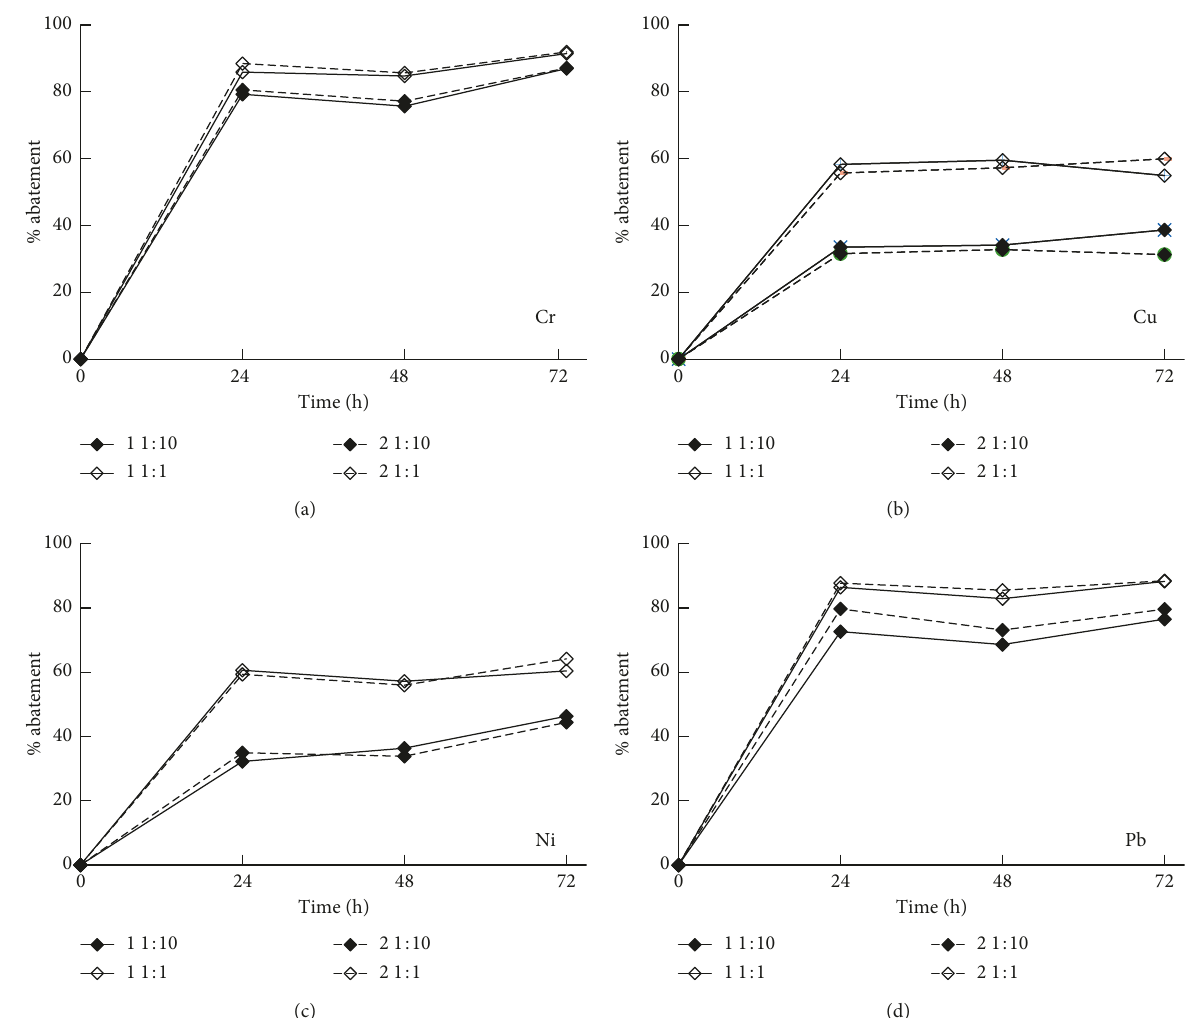
Figure 7: % abatement of Cr, Cu, Ni, and Pb as a function of time in acetate buffer (5 · 10 − 3 M) for Colonies 1 and 2 at 1:10 and 1:1 Water Kefir/metal solution ratios. Conditions: 5% sucrose and initial pH � 4.5. n � 3.